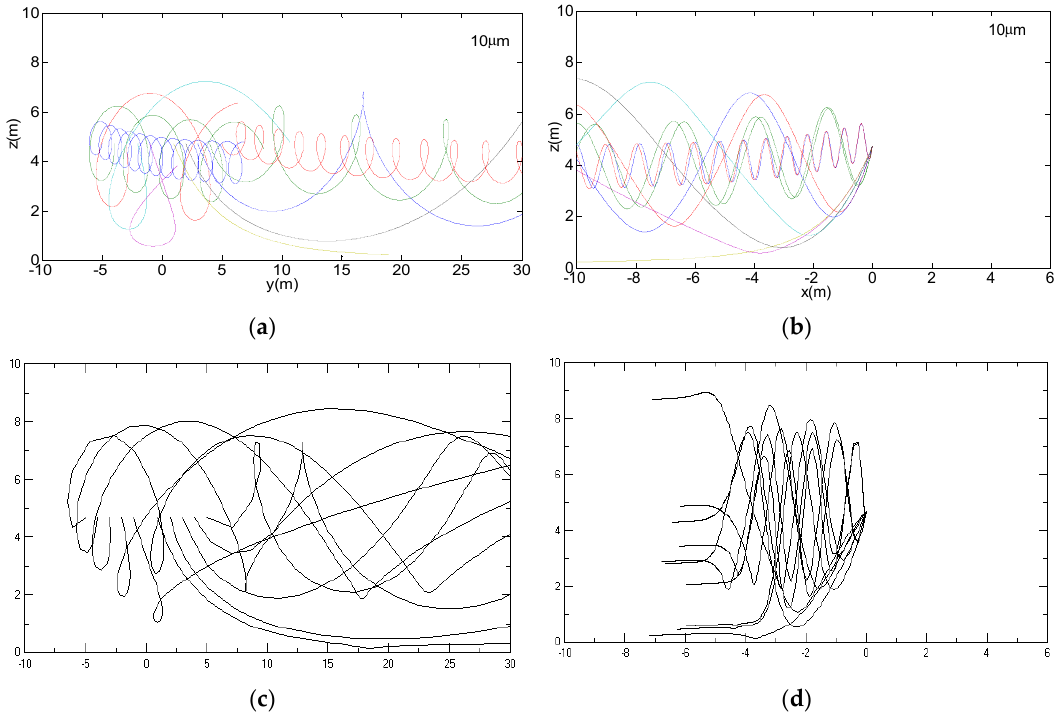
Figure 17. Comparisons of trajectories of 10 μ m droplets in the IGE model and AGDISP from two views, two respective figures in the up (IGE model) and down (AGDISP) have the same scale and unit of measure: ( a ) yz plane (rear view of an aircraft) based on IGE model; ( b ) xz plane (right view of an aircraft) based on IGE model; ( c ) yz plane (rear view of an aircraft) based on AGDISP; ( d ) xz plane (right view of an aircraft) based on AGDISP.